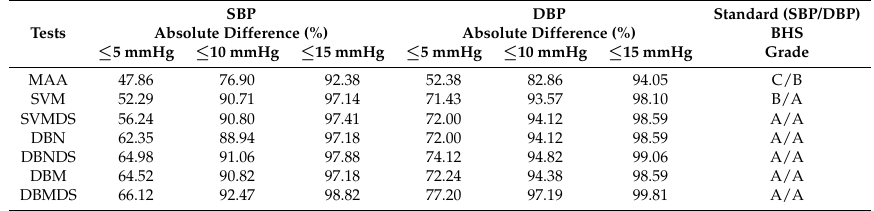
Table 4. Grading of the fusion scheme according to the BHS (Brithsh hypertension society) [27] standard employing the results of MAA, SVM [28], SVMDS, DBN, DBNDS, DBM, and DBM based DS fusion schemes on (5 × 85 = 425)